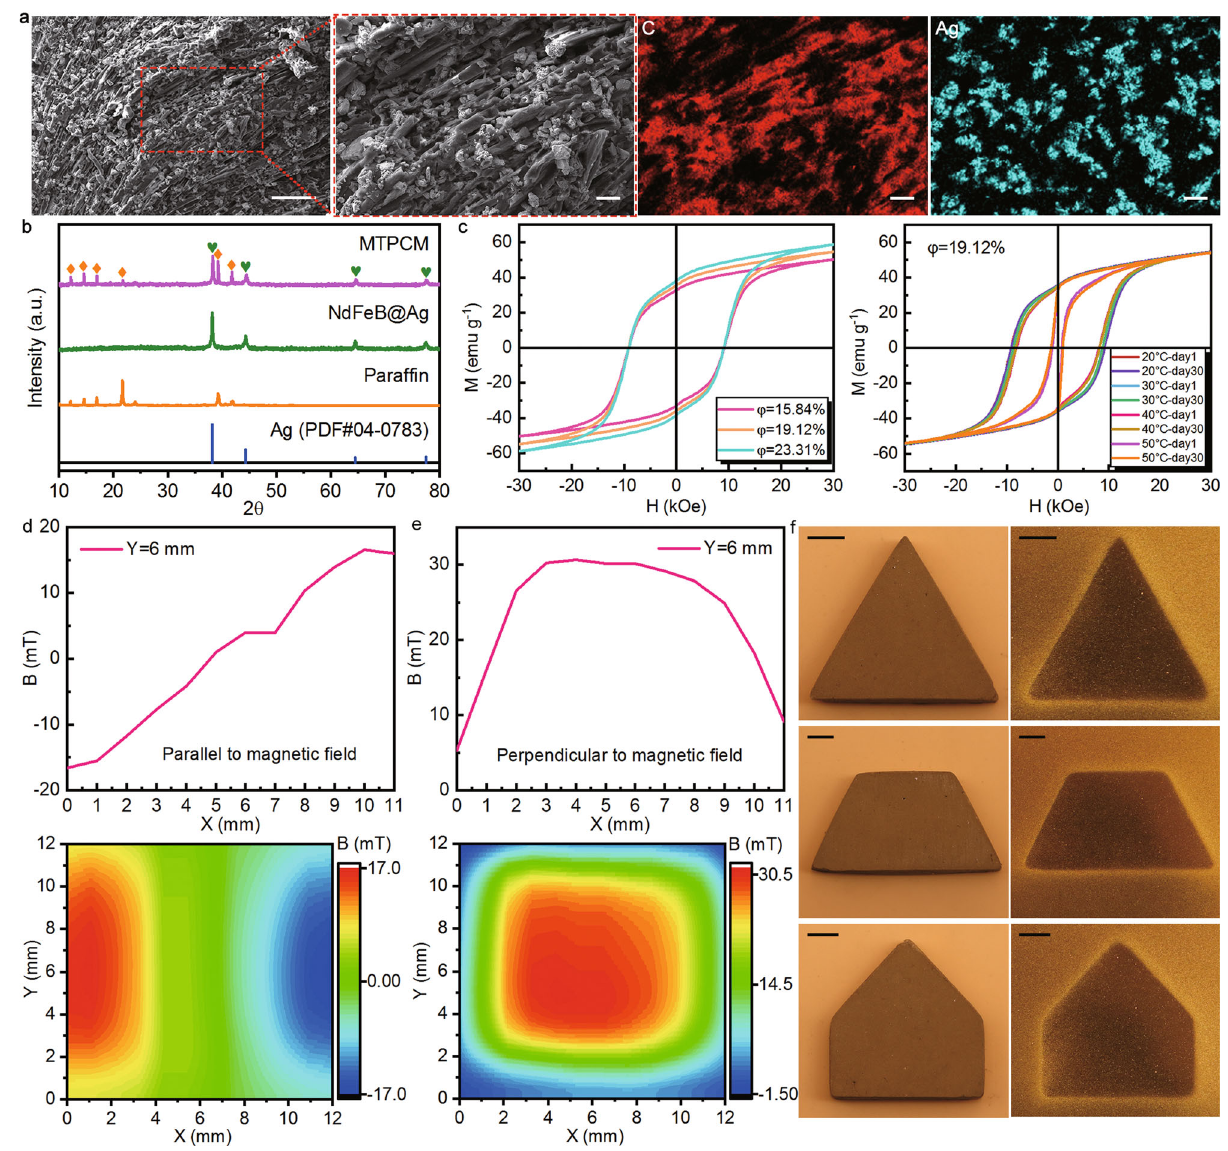
Fig. 2 Characterizations of magnetically tightened form-stable phase change materials (MTPCMs). a SEM images and the corresponding EDX element mappings for the cross-section of MTPCMs, revealing the directional alignment of NdFeB@Ag particles induced by the magnetic fi eld. Scale bars: 50 μ m, 10 μ m, 10 μ m and 10 μ m. b Comparison of XRD patterns among MTPCM, NdFeB@Ag, paraf fi n, and the PDF card of pure Ag. c Magnetic hysteresis loops of MTPCMs with different volume ratios and the typical MTPCM sample at different temperatures at different time points. d , e Surface magnetic fl ux density of MTPCM in the direction along and perpendicular to the magnetic fi eld. f Surface magnetic fi eld distributions of MTPCMs with different shapes. Scale bars: 4